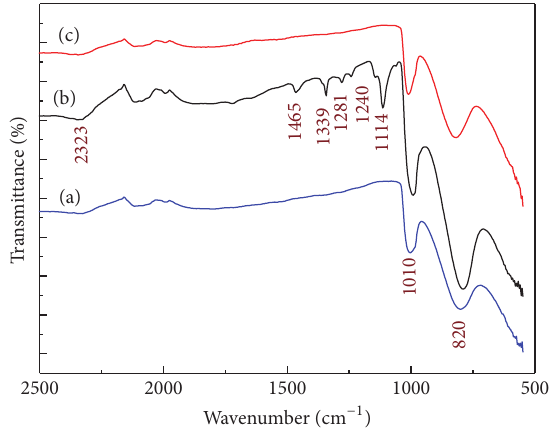
Figure 6: Infrared spectra of commercial V 2 O 5 (a), V 2 O 5 obtained through the surfactant assisted technique before calcination (b), and synthesized V 2 O 5 after calcination (c).